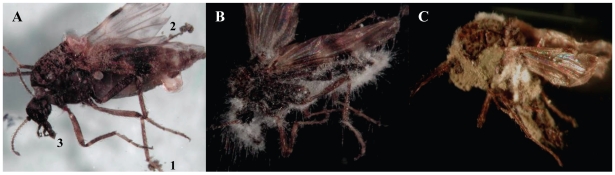

Culiocides nubeculosus midges at different times after contact with ‘dry’ conidia of Metarhizium anisopliae V275.(A) Adult Culiocides nubeculosus 1 day after death showing conidial attachment to the ‘feather’ of the last few tarsae (1), and several on the ‘feather’ of the tibia (2) and around the proboscis (3). (B) An adult midge cadaver 3 days after death showing hyphal growth of Metarhizium anisopliae V275. (C) An adult midge cadaver 6 days after death showing sporulation of fungus.